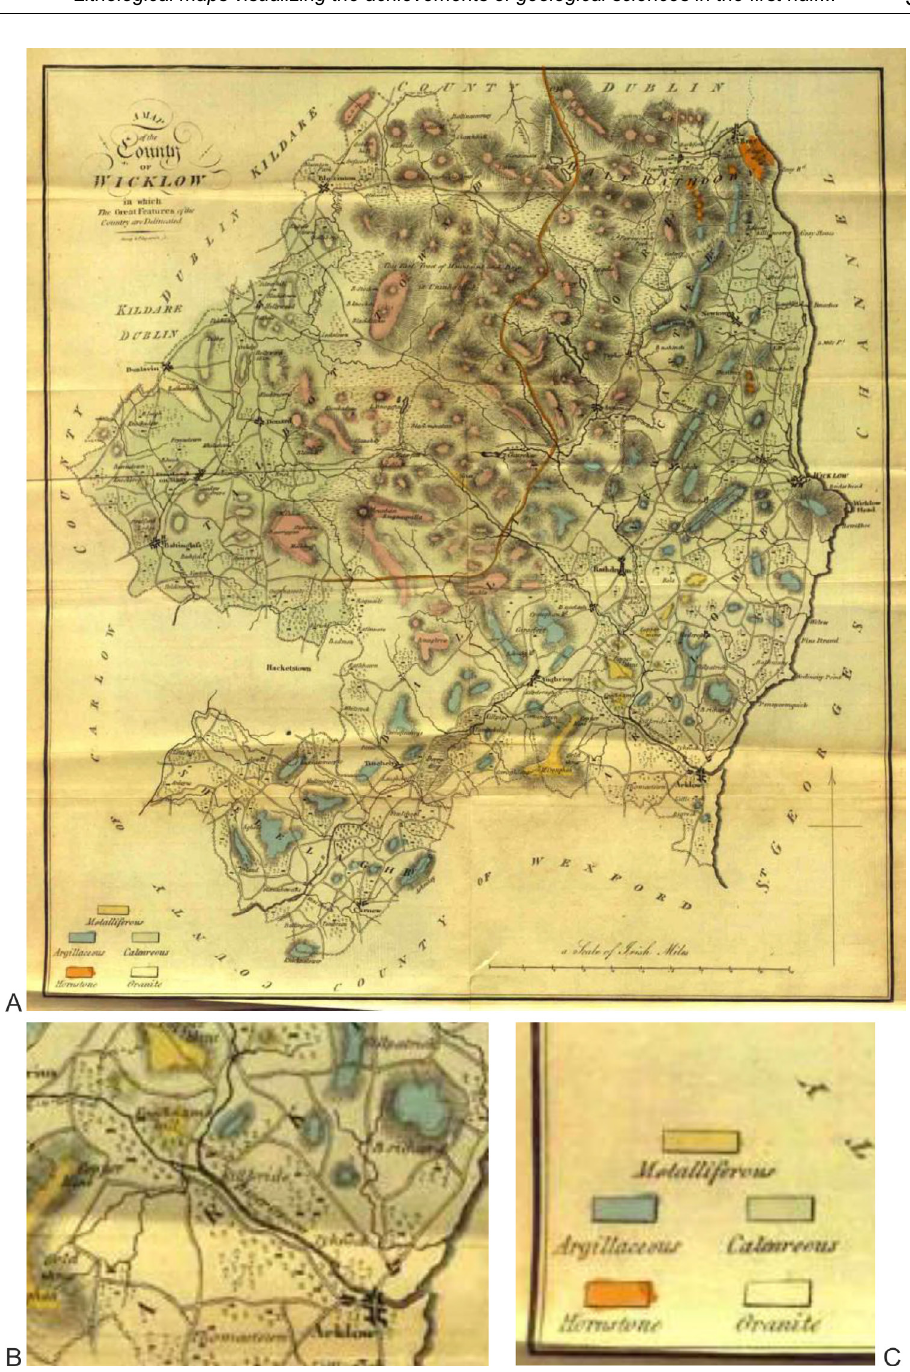
Fig. 3. The map of Wicklow County created by Robert Fraser in 1801 − A, its selected section − B, and the explanation with five categories of rock strata − C (from the collection of the Wicklow County